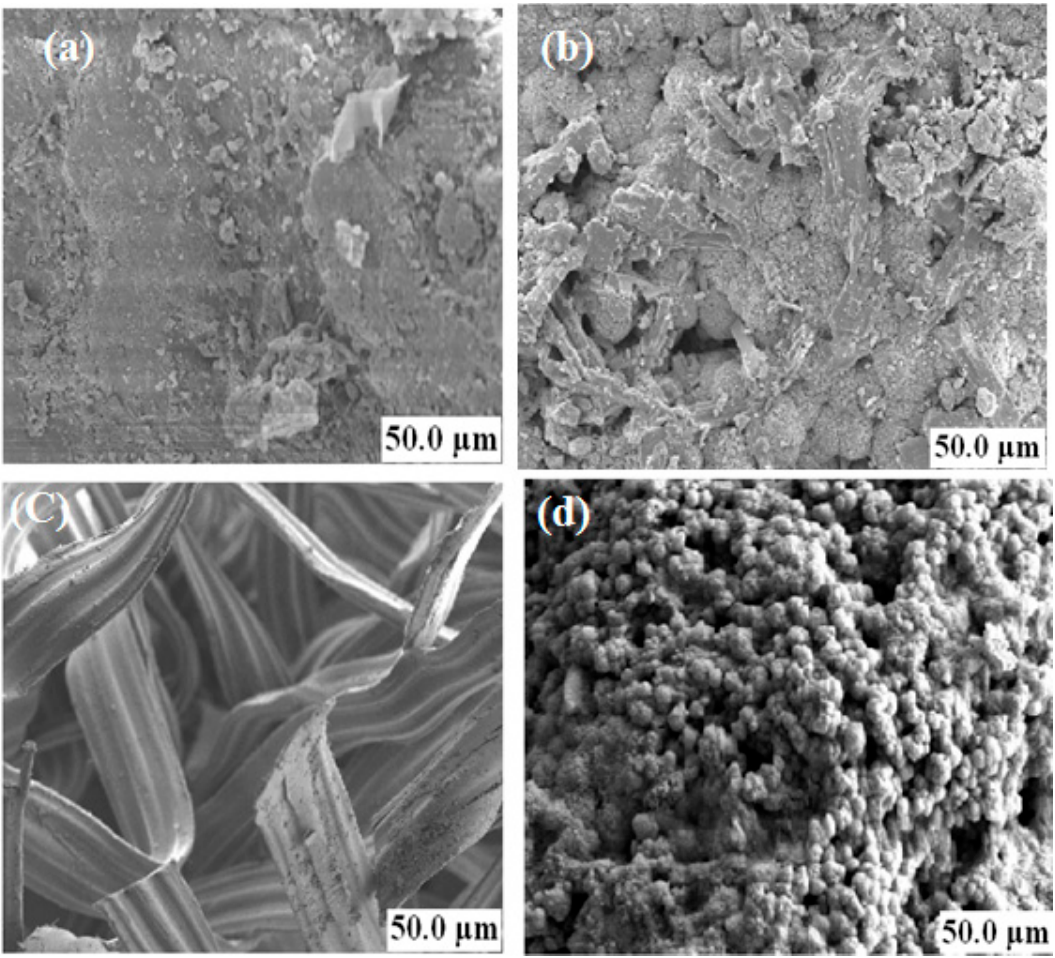
Figure 9. The SEM image of a conventional UASB reactor R1 before ( a ) and after ( b ), and a modified UASB R2 reactor before ( c ) and after ( d ) contact with CSWW.